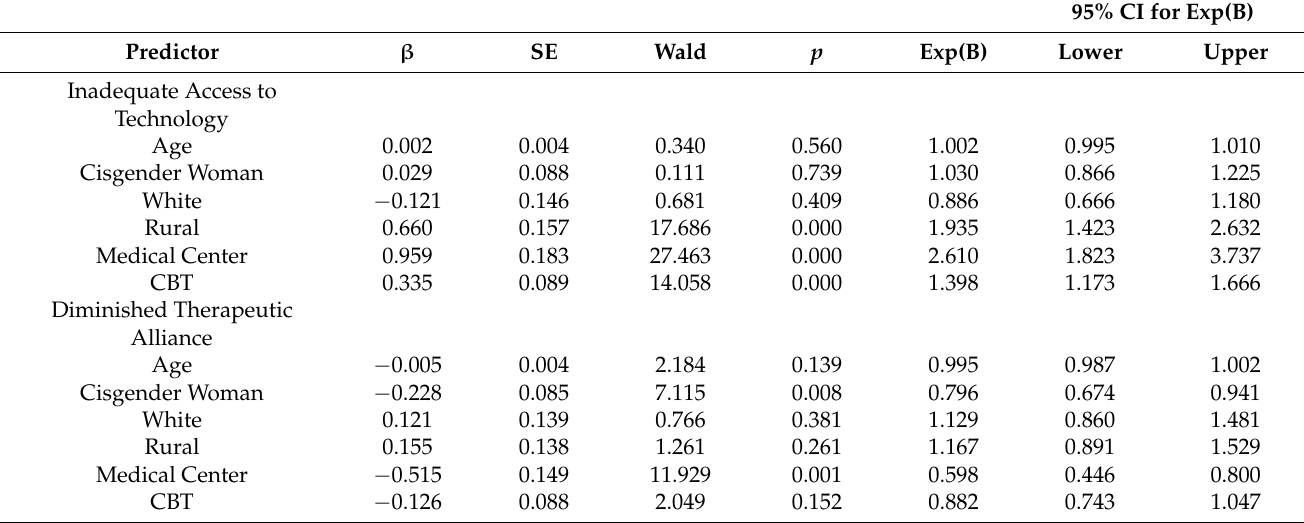
Table 4. Variables in the Logistic Regressions for